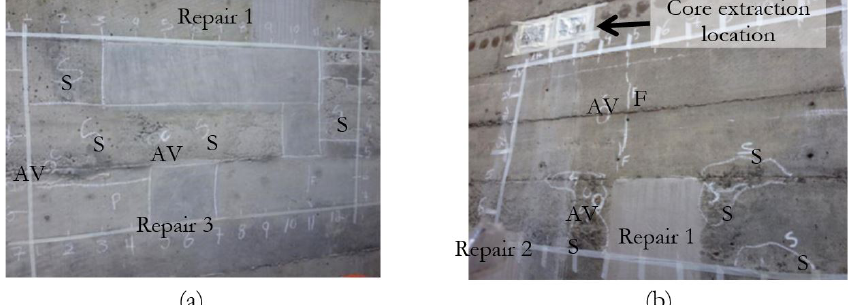
Figure 6. General aspect of the area inspected with identification of repairs: (a) on SW façade and (b) on NW façade (Photos: Authors’ collection,